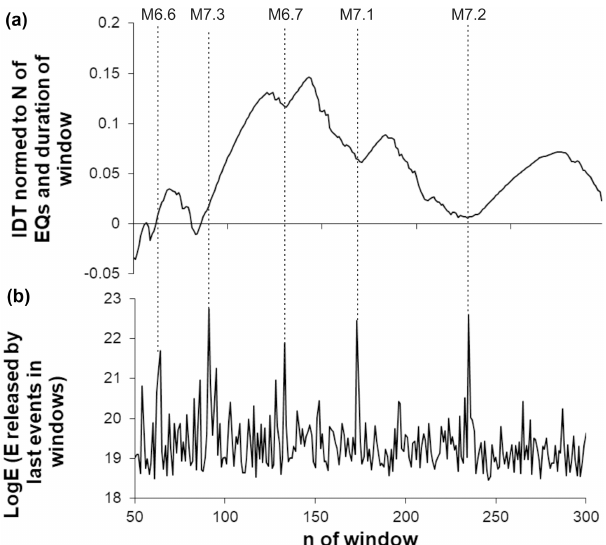
Figure 10. Calculated for the expanding (by consecutive 10 data) windows, integral deviation times (IDTs) (a) and the increments of seismic energies released by 10 last events in consecutive win- dows (b) obtained from the southern California earthquake catalog (above threshold M = 3 . 6). By the grey lines we show where the IDT curve comes closest to zero value. Dashed lines show the oc- currence of largest earthquakes in the